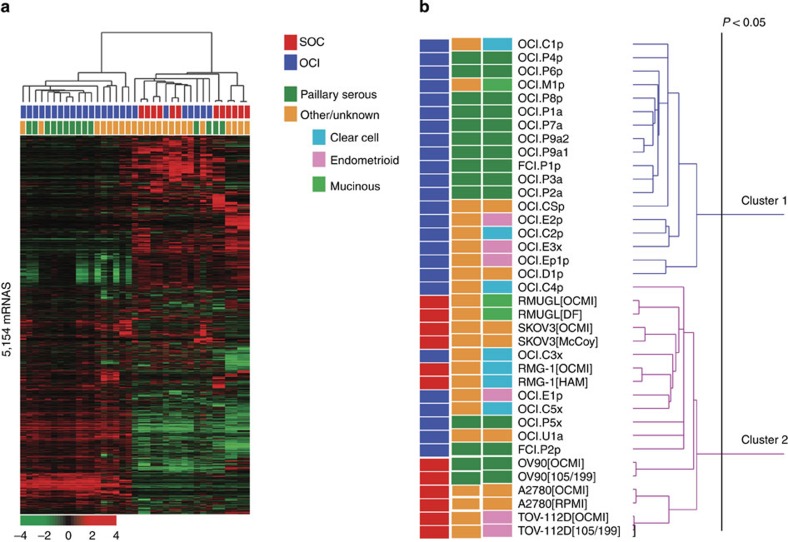
mRNA profiling of OCI cell lines identifies two major clusters.(a) Unsupervised hierarchical clustering of mRNA expression levels of OCI (blue bars) and SOC (red bars) ovarian cancer cell lines reveal two clusters. Genes with ≥2-fold difference relative to the median value in at least four cell lines were selected for hierarchical clustering analysis (5,146 gene features). Rows represent individual genes and columns represent each cell line. The red and green colours reflect relative high and low expression levels, respectively, as indicated in the scale bar (log2-transformed scale). Two major clusters are observed: cluster 1 contains only OCI cell lines (left cluster, blue only), and cluster 2 contains a mixture of SOC and OCI cell lines (right cluster, red and blue). While the papillary serous histotype almost exclusively align within cluster 1 (green bars), the other subtypes are present in both clusters (orange bars). See Supplementary Methods, Supplementary Figs 10 and 11 and Supplementary Tables 8–11 for more detailed information. The complete mRNA expression data set is available at Gene Expression Omnibus, GEO accession number GSE40788. (b) The dendogram of the cell lines that make up the two clusters in the heatmap in a. The cell line names are coloured as follows; first column, OCI (blue) and SOC (red); second column, papillary serous (dark green) and other histotypes (orange); third column, papillary serous (dark green), clear cell (light blue), endometrioid (pink), mucinous (light green) and other histotypes (orange).